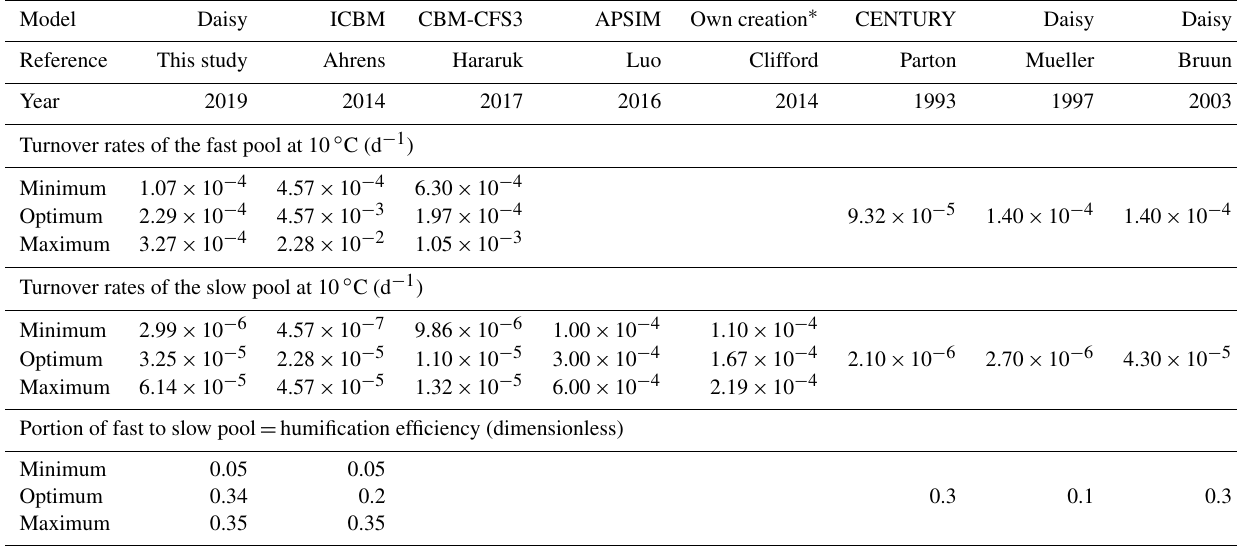
Table 5. Optimized turnover rates and humification efficiency of this study (using the combined site analysis with original weighting and the DSI) compared to other Bayesian calibrations and standard values of commonly used models. Turnover rates of other models were normalized to the Daisy standard of 10 ◦ C using an exponential equation (an exception was Clifford et al., 2014, where no temperature was